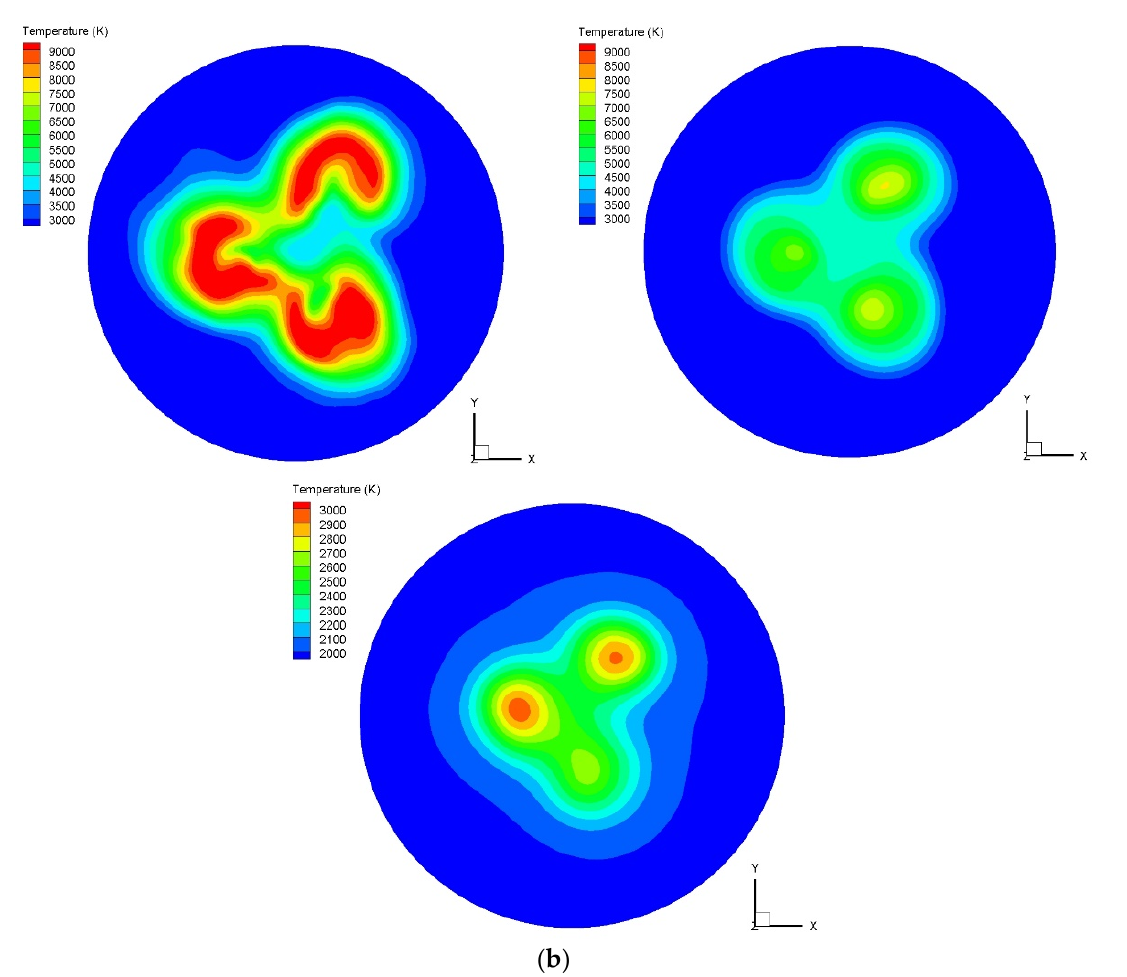
Figure 8. ( a ) Arc temperature distribution (longitudinal section). ( b ) z = 0.65 m, 0.35 m, 0.15 m arc temperature distributions (cross ‐ section).